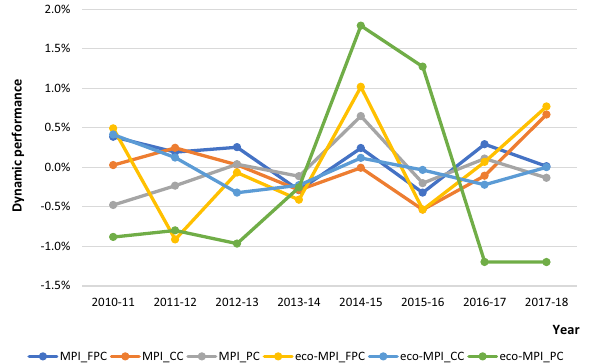
Fig. 1 Productivity and eco-productivity change of Chilean water companies. Average estimates of productivity change (MPI) and eco-productivity change (eco-MPI) and its drivers ’ ef fi ciency change (EC) and technical change (TC). Published in partnership with King Fahd University of Petroleum & Minerals npj Clean Water (2023)